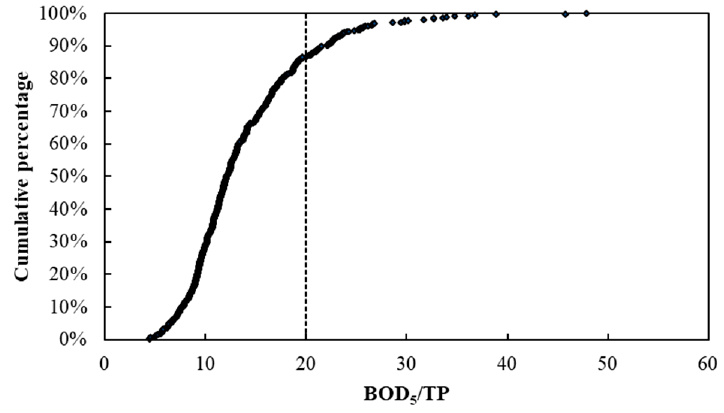
Figure 13. BOD 5 /TP cumulative distribution in the CAST process.